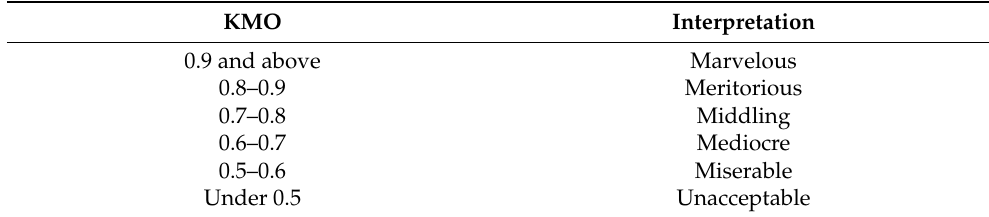
Table 1. Interpretation Of KMO